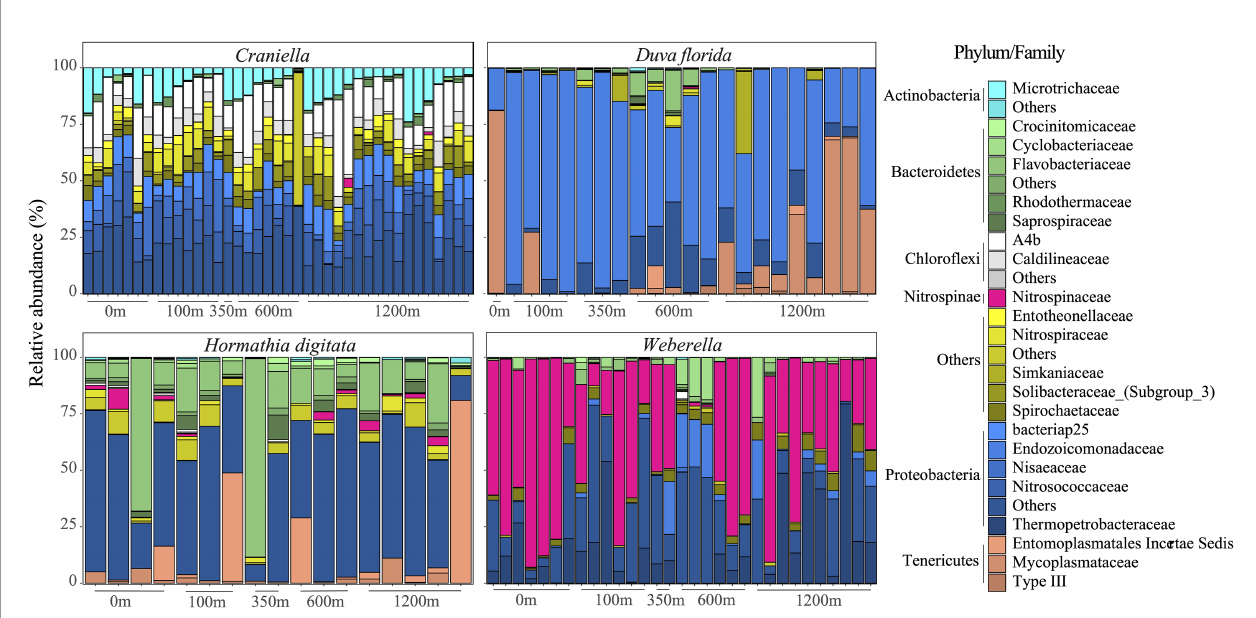
FIGURE 3 | Bar plots of the bacterial taxonomic composition (families and phyla) of samples per epibenthic taxa across distance from the fi sh